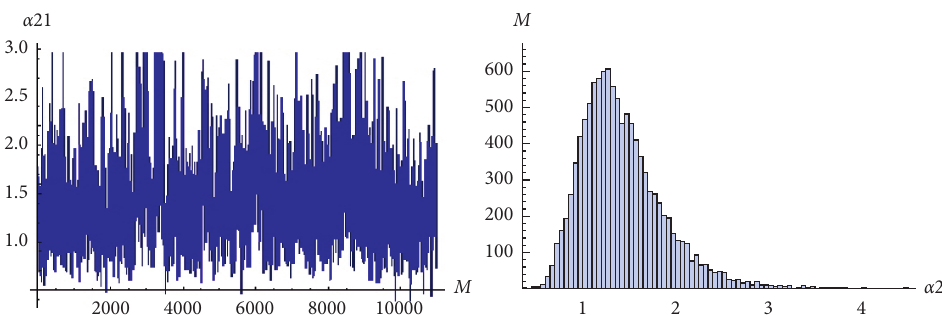
Figure 6: Simulation MCMC generated number/histogram of the parameter β